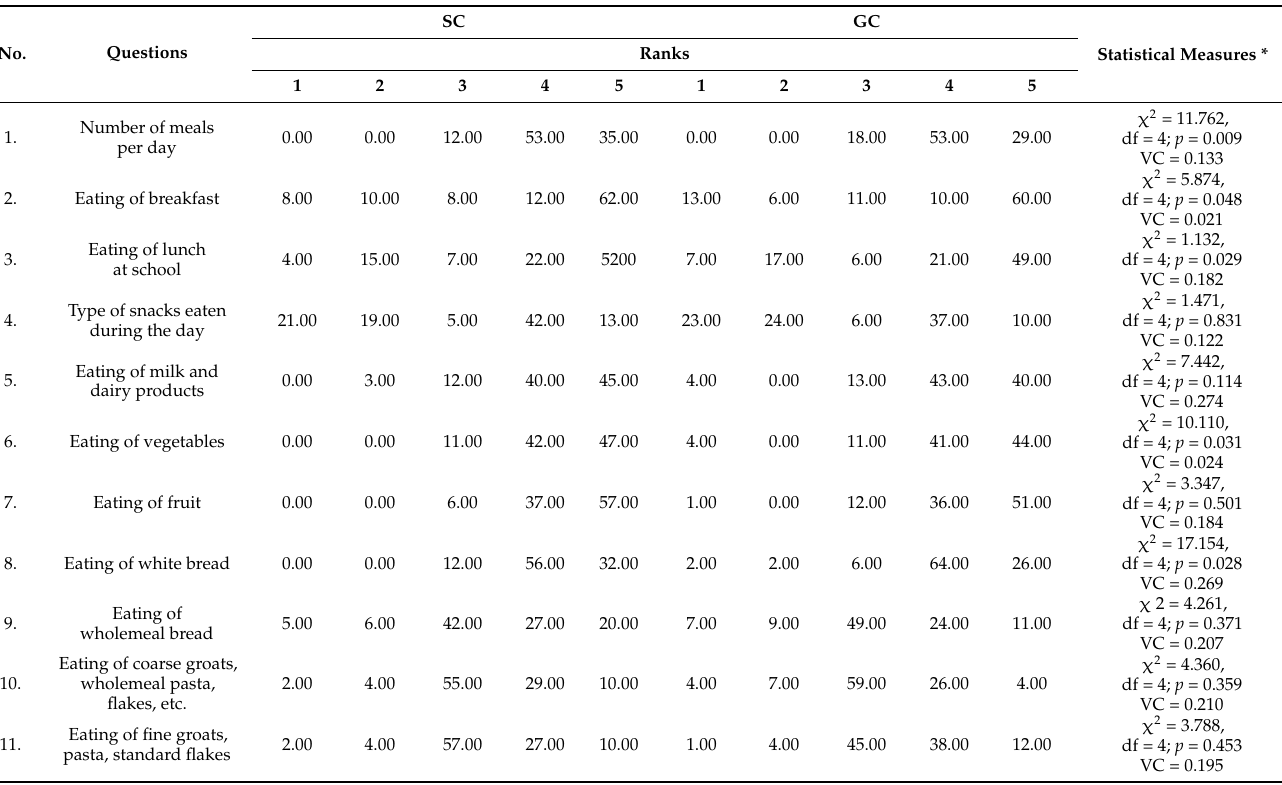
Table 3. Eating behaviour of SC and GC children in the middle assessment session (2018), % of particular ranks in the